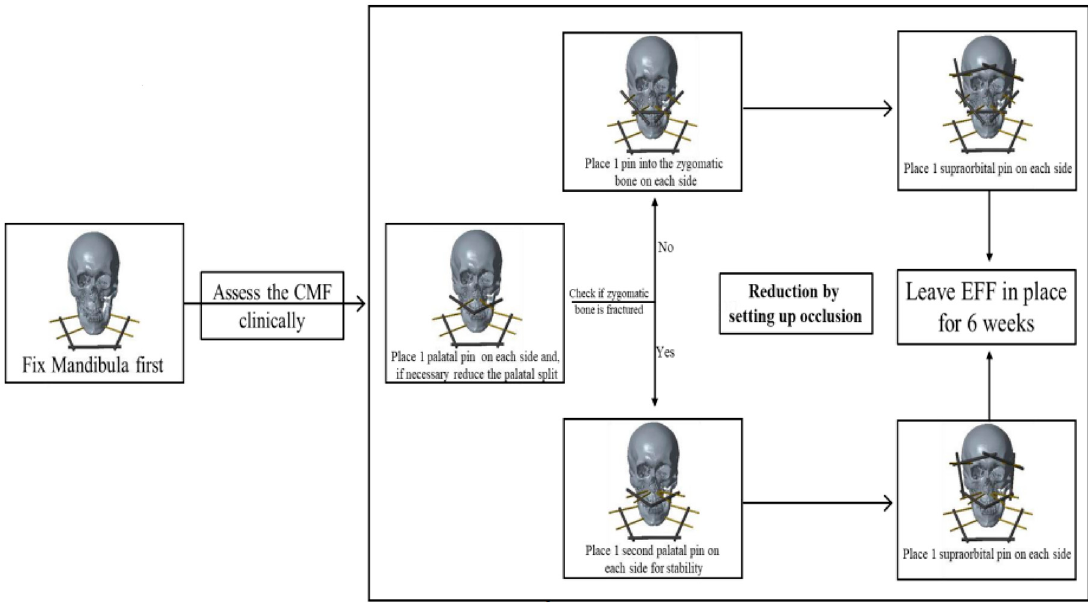
Figure 4. Flowchart and decision-making of the operation technique of the External Face Fixator (EFF) for Craniomaxillofacial fractures